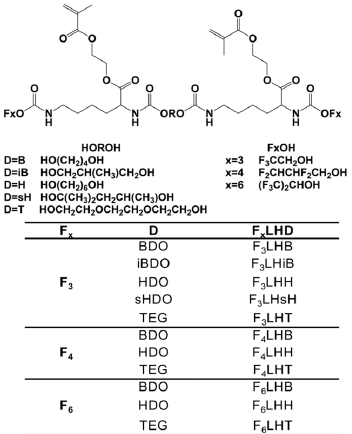
Figure 1. Schematic and nomenclatures of fluorinated monomers (F x LHD).